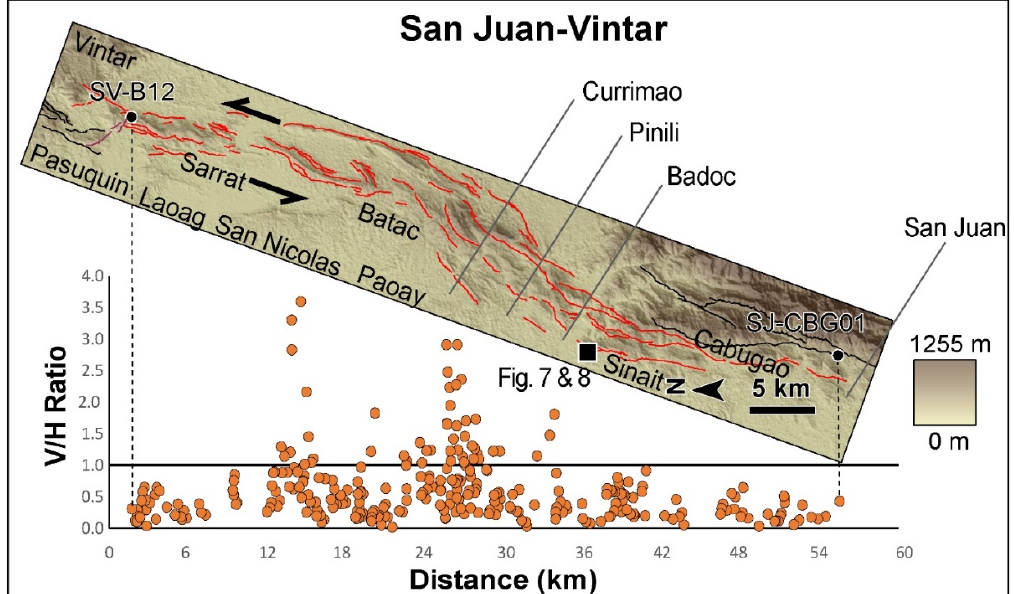
Figure 6. Map of the trace from San Juan to Vintar (labeled ‘b’ in Figure 2A) above the offset plot for this part of the Vigan-Aggao Fault. The fault zone is marked by a broad bend within a right-step gap. The San-Juan Vintar segment is traced in red, while the northern portion of the Santa-Sinait segment is traced in black. The transition between these segments is traced in violet.